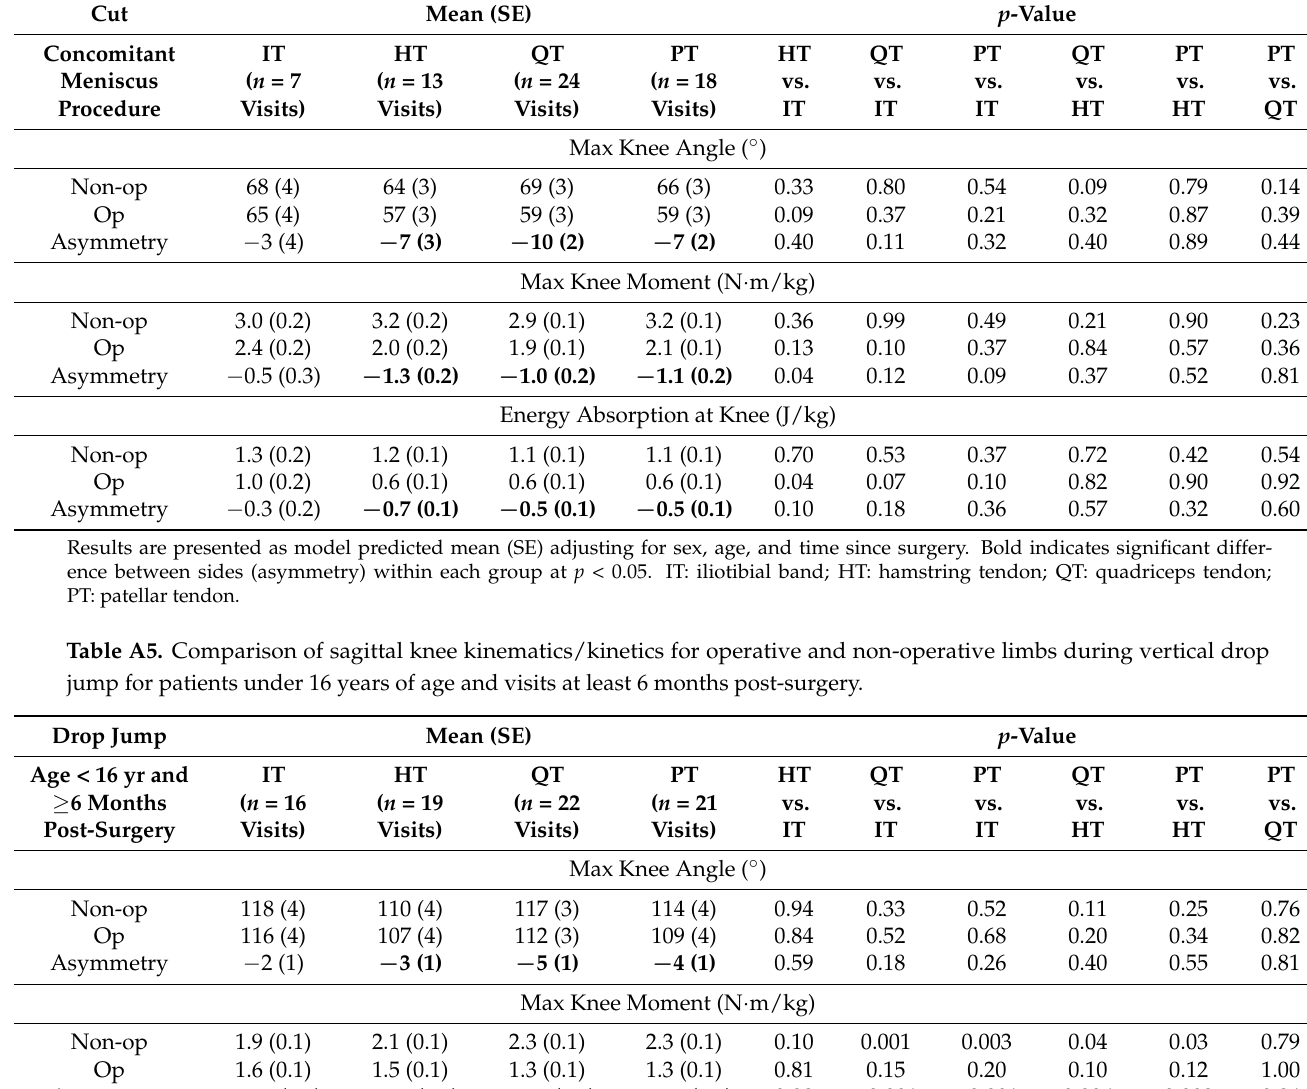
Table A4. Comparison of sagittal knee kinematics/kinetics for operative and non-operative limbs during cutting for patients with concomitant meniscus repair, debridement, or meniscectomy. Cut